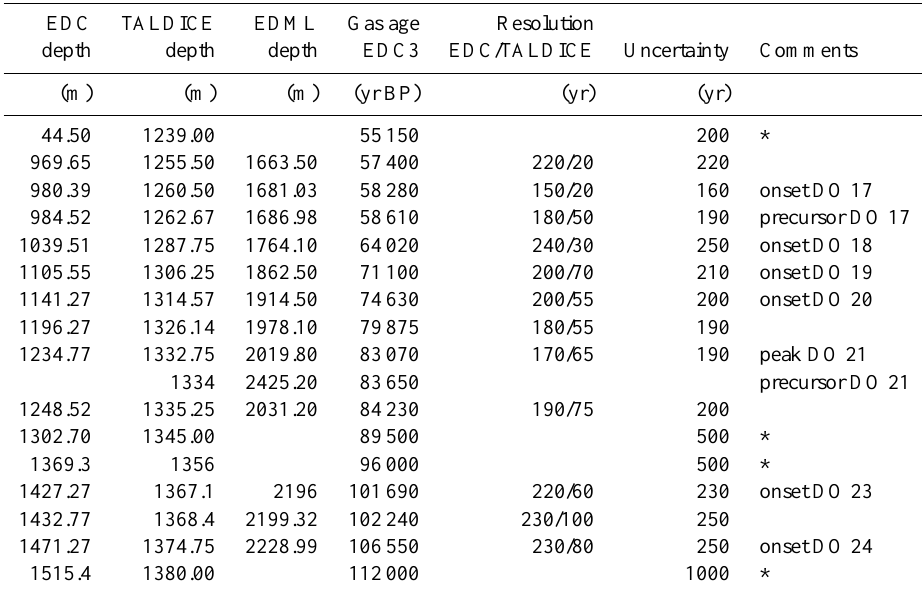
Table 1. Tie points defined in the age interval from 55–112 ka BP by synchronization of the new high-resolution TALDICE CH 4 data with the EDC CH 4 record on the EDC3 age scale. The indicated uncertainty is from visual matching of TALDICE and EDC only. Additionally indicated are the corresponding depths of the EDML ice core for all the new tie points and the sample resolutions of the EDC and TALDICE CH 4 records, respectively, for each tie